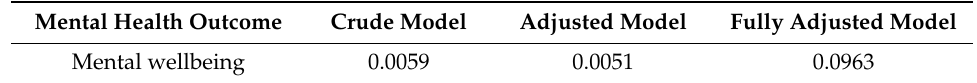
Table A7. p -Values from the ANOVA type II test of deviance of the regression, examining the association of the entire 24 h movement composition (consisting of at least VPA, MPA, LIPA, SED and time in bed) with mental